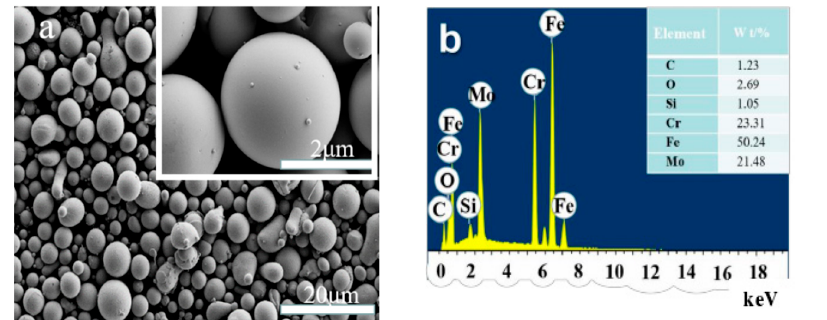
Figure 1. ( a ) SEM morphology and ( b ) EDS composition analysis of FeCoCrMoBCY amorphous alloy (FAA) powders.